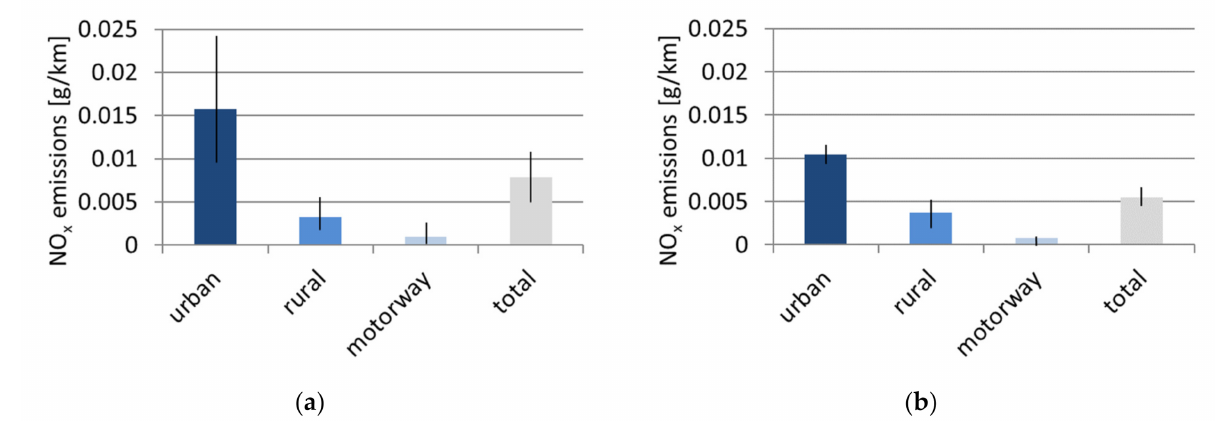
Figure 11. Influence of driving mode on the real-world nitrogen oxides (NO x ) emissions of the studied PHEV during summer time. ( a ) Hybrid driving mode; ( b ) Sport driving